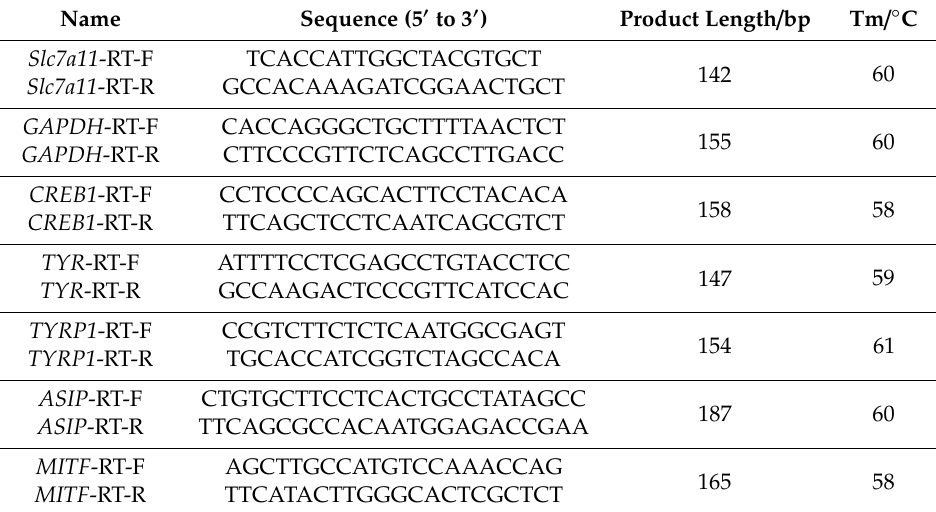
Table 3. Primer sequences used for real-time